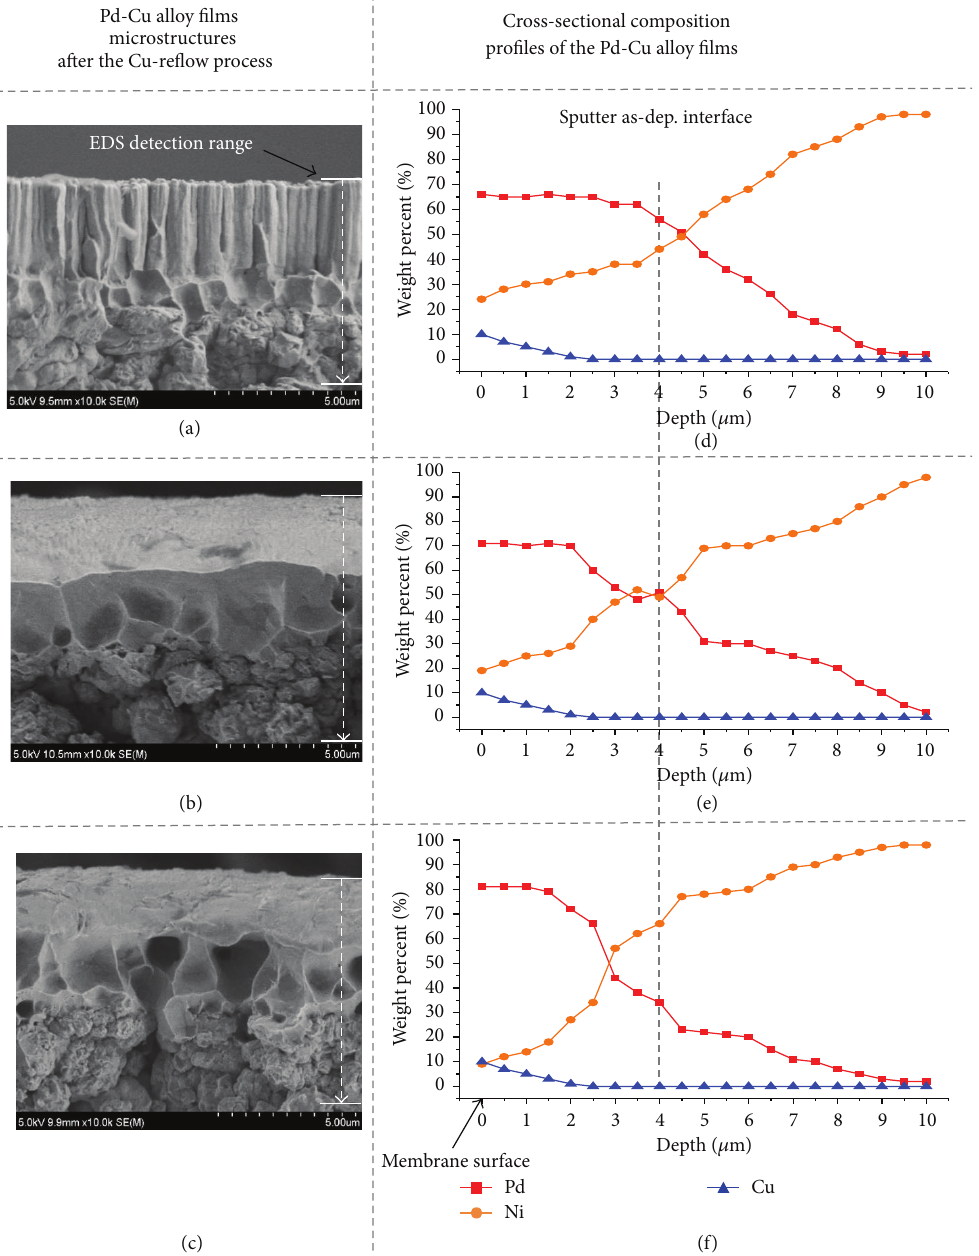
Figure 4: The cross-sectional FE-SEM images and composition profiles of the heat-treated Pd-Cu alloy films with 4 𝜇 m thickness for various interface structures depending on the sputter as-deposited microstructures: (a), (d) closed interface; (b), (e) partially open interface; (c), (f) open interface; arrow lines in (a), (b), and (c) are EDS detection